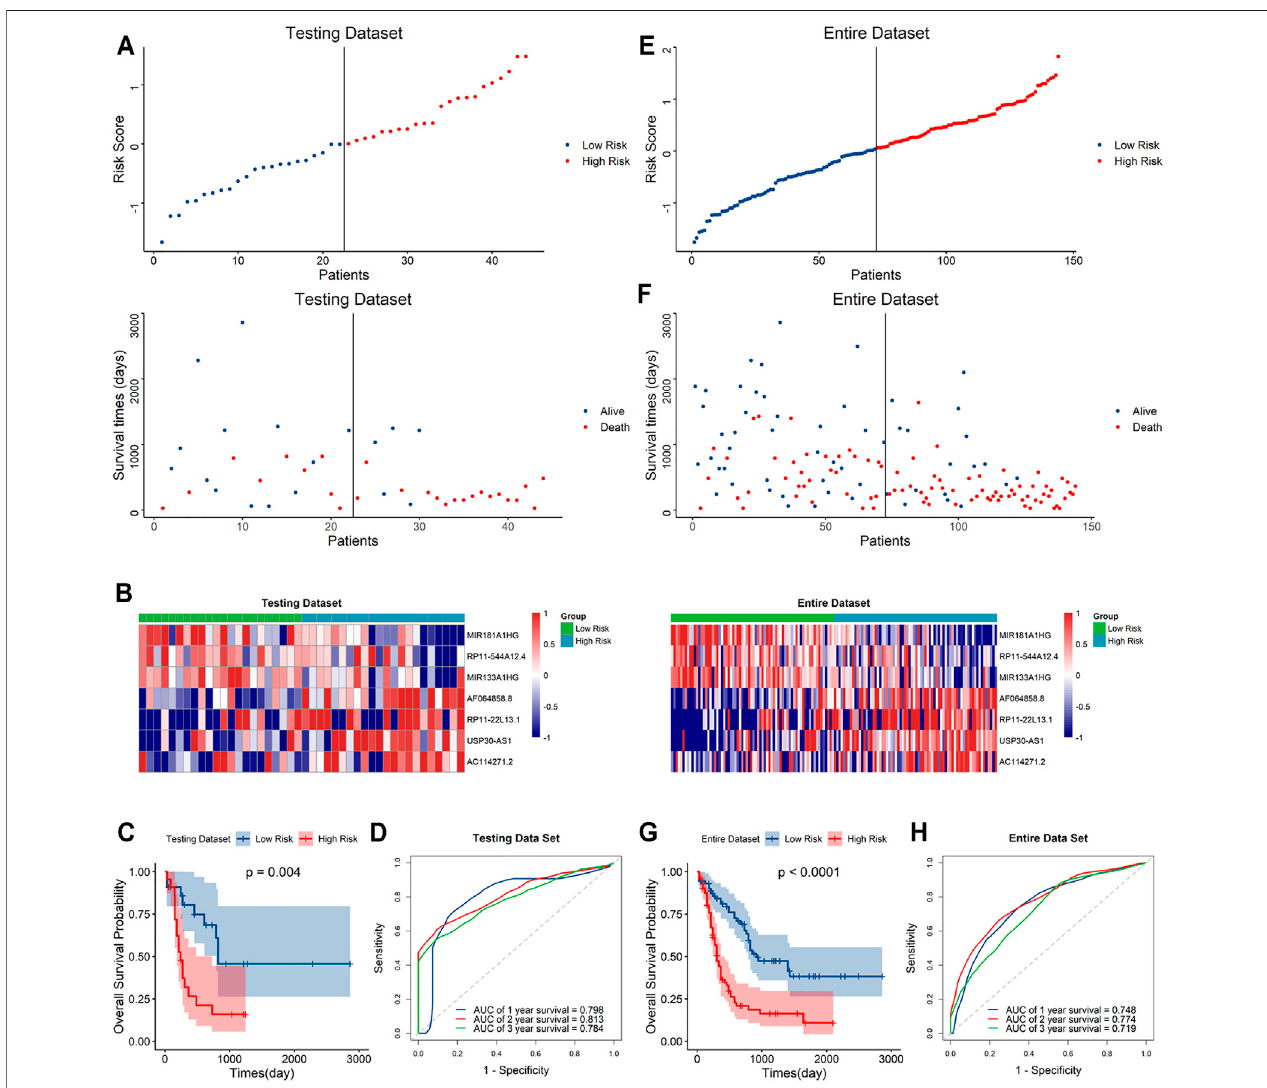
FIGURE 4 | Evaluation of the signature in the testing and whole datasets (A,E) . Distribution of the risk score (top) and survival time of each patient (bottom) in the testing dataset (A) and whole dataset (E) . (B,F) Expressionof theseven lncRNAsinthe high- and low-riskgroups in the testing dataset (B) and whole dataset (F) . (C,G) Kaplan – Meier curve analysis of the signature in the testing dataset (C) and whole datasets (G) . (D,H) ROC curves and their AUC values showed 1-, 2-, and 3-year predictions in the testing set (D) and whole dataset (H) .